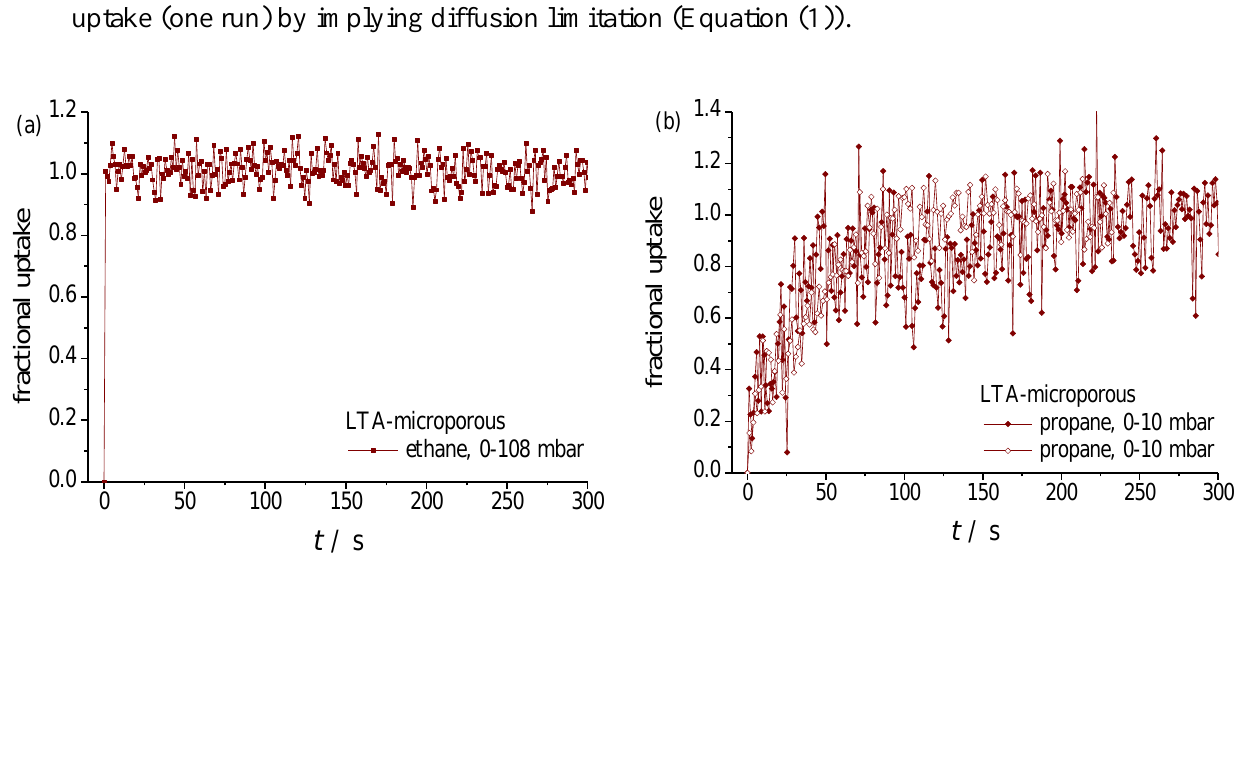
Figure 8. Uptake of ( a ) ethane; ( b ) propane (two different symbols, corresponding to two different runs) at 298 K on a single crystal of type NaCaA-0; and ( c ) fitting of propane uptake (one run) by implying diffusion limitation (Equation